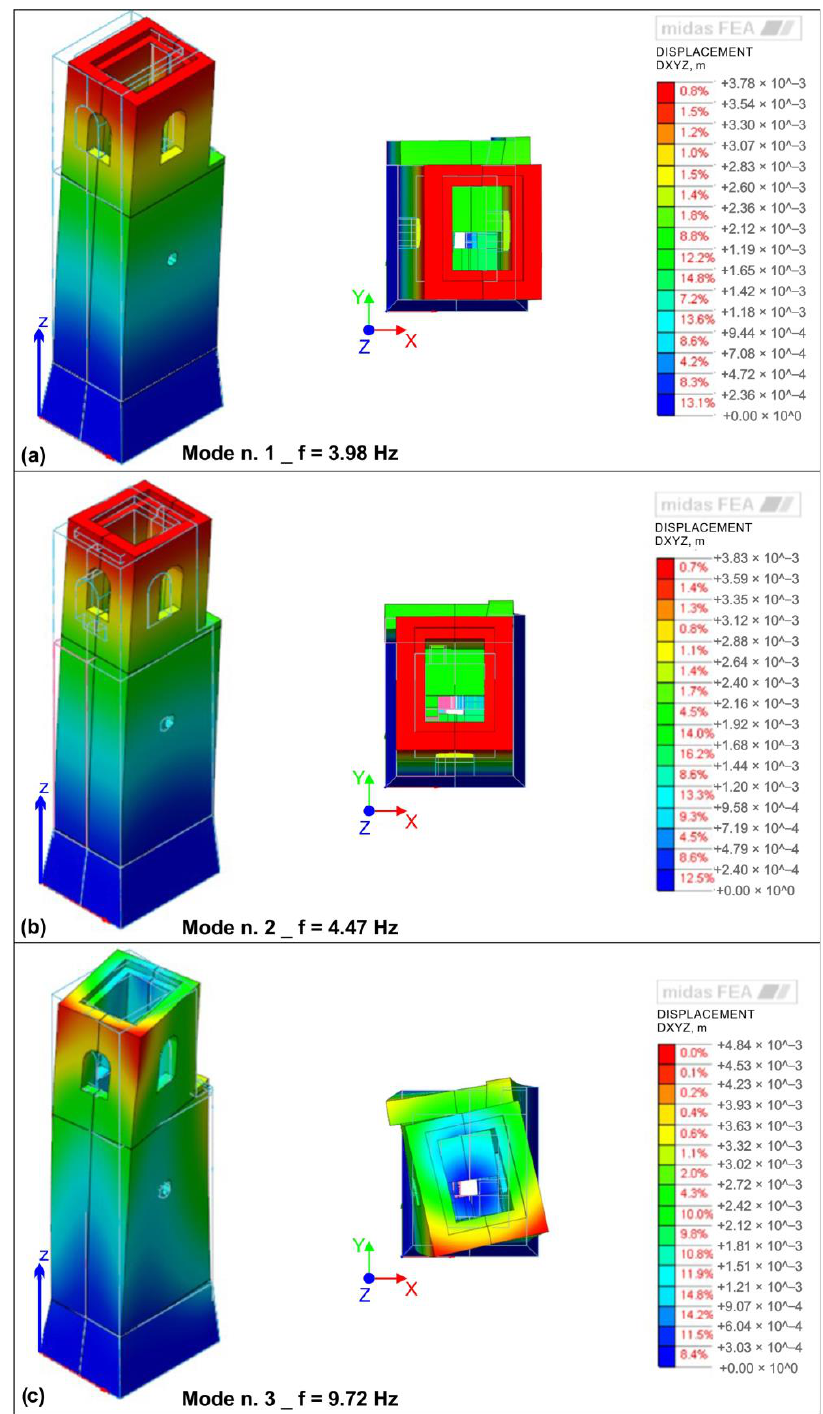
Figure 13. Perspective and plan views of the mode shapes of San Giuseppe’s bell tower (Aci Castello, Sicily) identified from numerical analysis on Midas FEA. ( a ) Mode n. 1, bending around Y-axis (i.e., north – south axis); ( b ) mode n. 2, bending around X-axis (i.e., east – west axis); ( c ): mode n. 3, torsional around Z-axis (vertical axis).